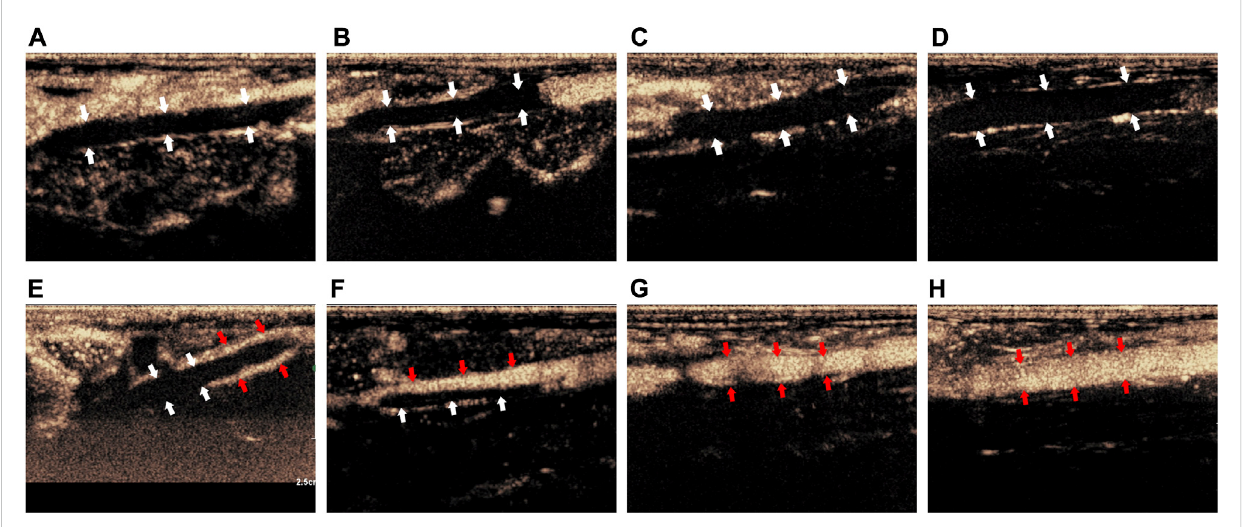
FIGURE 3 Comparison of imaging by CEUS of the thrombus before and after treatment. (A – D) Corresponded to the Group I-IV before treatment; (E – H) corresponded to the Group I-IV after treatment. The white arrow indicated the thrombus in the blood vessel, the red arrow indicated the contrast agent that passes through the vessel after recanalization.